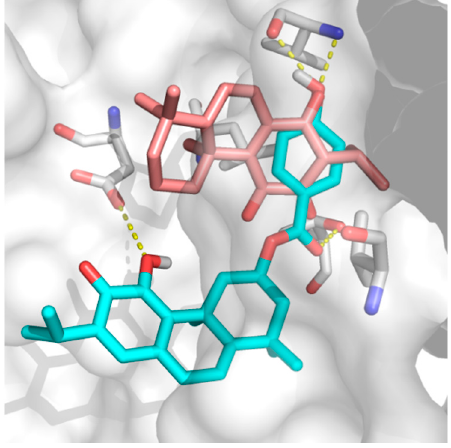
Figure 6. Docked binding poses of ( 3 ) ParvD (cyan) and ( 1 ) DeRoy (pink) in the binding site of PKC ι.